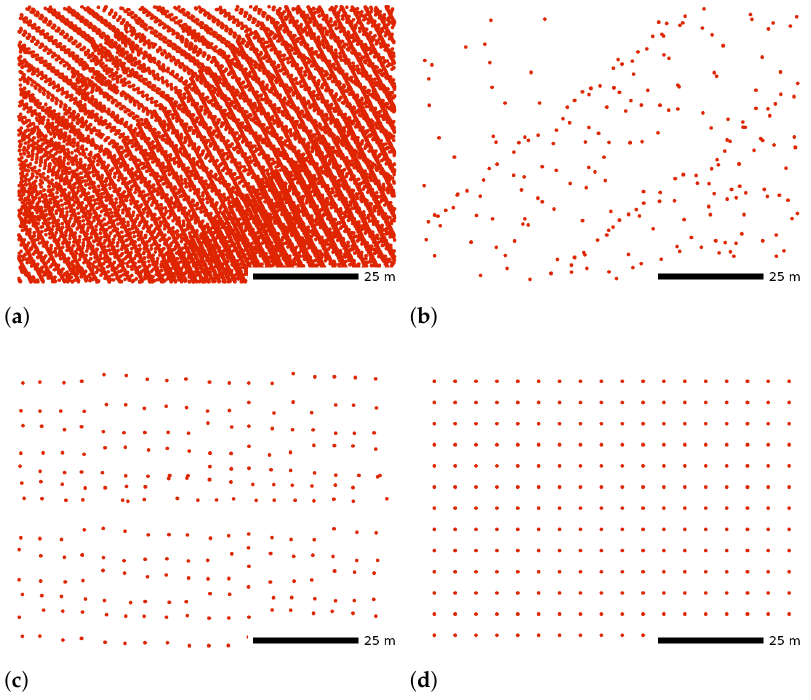
Figure 16. ( a ) Point cloud decimated using ( b ) count-based decimation keeping 1% of points (pre- serving every 100th point); ( c ) grid-based decimation preserving one point per 5 meter grid cell; ( d ) grid-based decimation with snapping to grid using the same 5 meter grid. Dataset: Wake County 2013